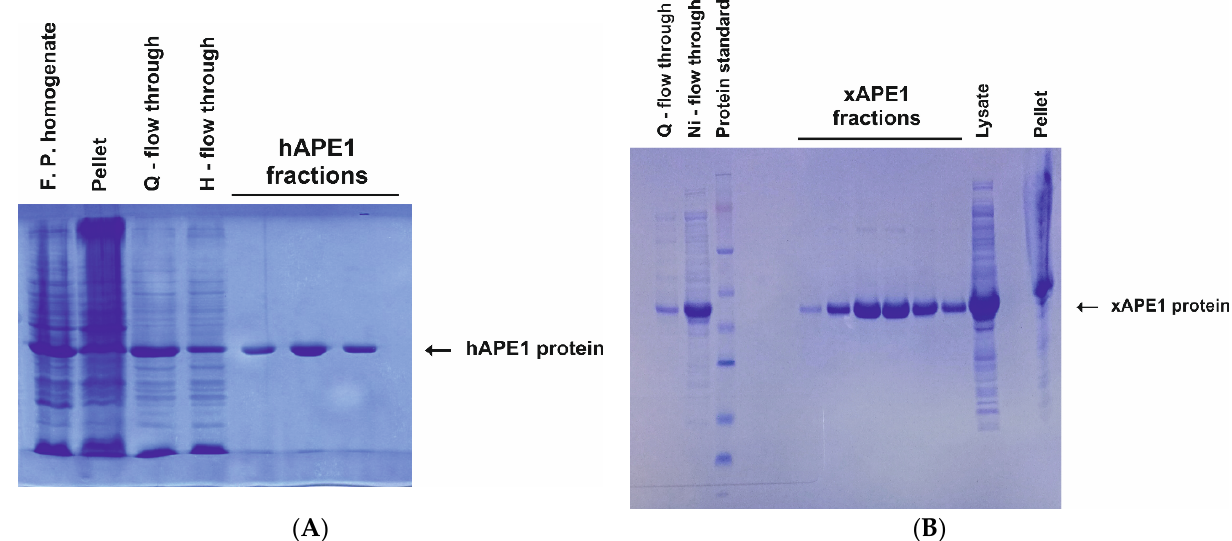
Figure 6. Analysis of the protein purity of the hAPE1 ( A ) and the xAPE1 ( B ) proteins by PAGE. The probes containing the homogenate obtained by the French-Press procedure, the cell pellet, the flow-through fractions after the Q-Sepharose chromatography, and the Heparin (hAPE1) or Ni-chelating (xAPE1) chromatography, as well as the protein fractions obtained by gradient elution of protein from the heparin/Ni-chelating columns were analyzed. Coomassie Brilliant Blue R-250 (Sangon Biotech, Shanghai, China) staining was performed for protein visualization.